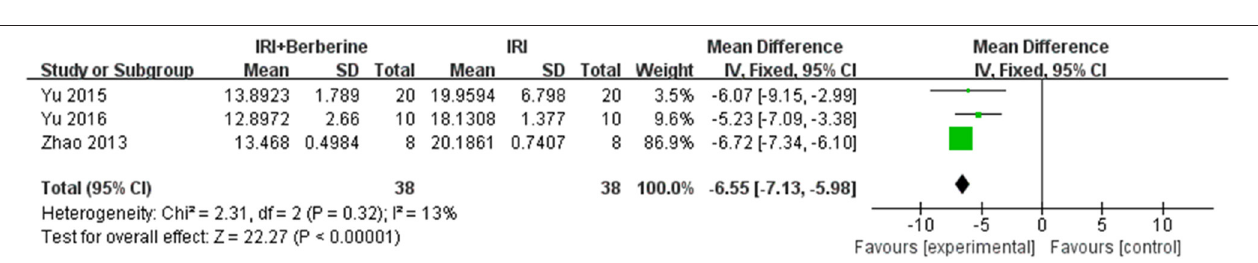
FIGURE 11 | Forest plot showing the effects of BBR on decreasing LDH compared to the control group.